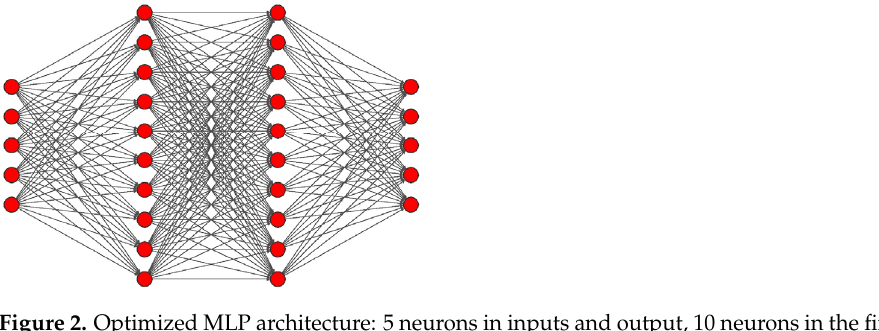
Figure 2. Optimized MLP architecture: 5 neurons in inputs and output, 10 neurons in the first, second and third hidden layers, each using the sigmoidal tangent activation function. The output layer was implemented with the Softmax activation function.